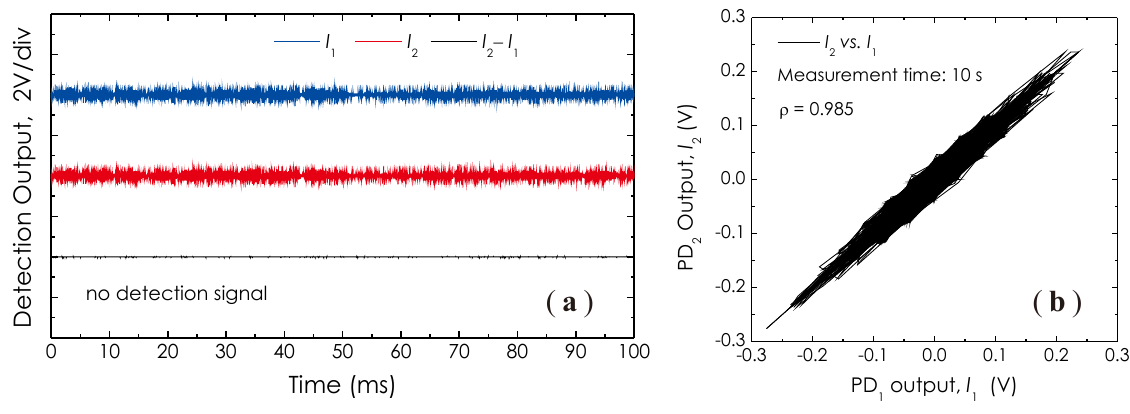
Figure 12. Measured results: ( a ) three signal waveforms from the sensor; ( b ) cross-correlation of two detection